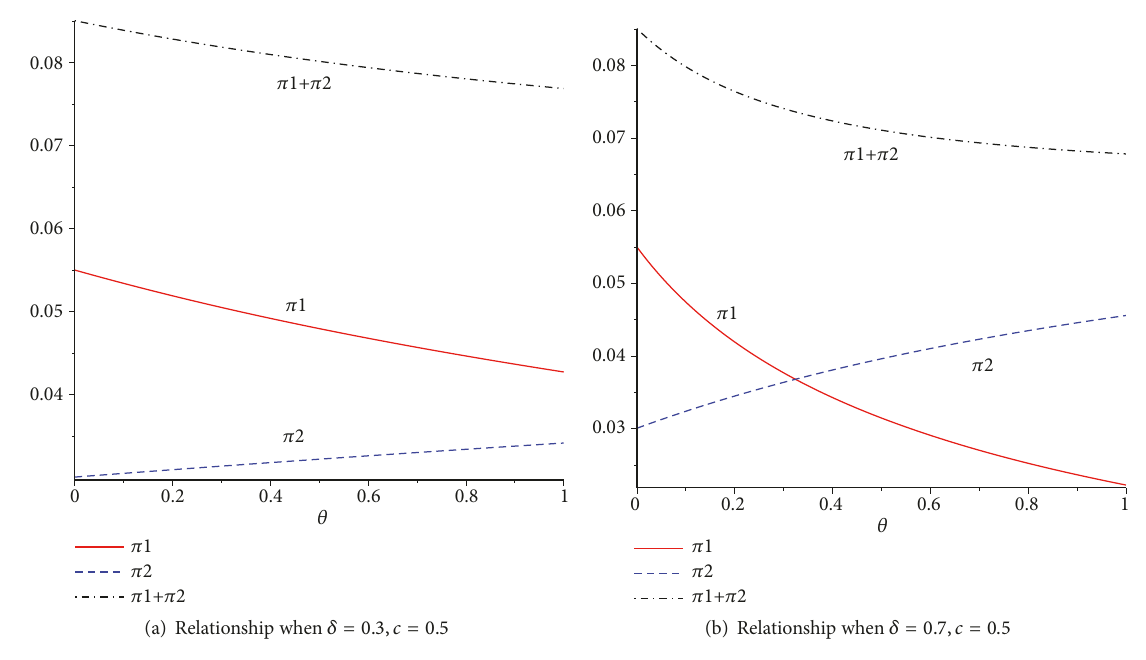
Figure 5: Relationship between proportion of strategic consumers 𝜃 and seller’s expected